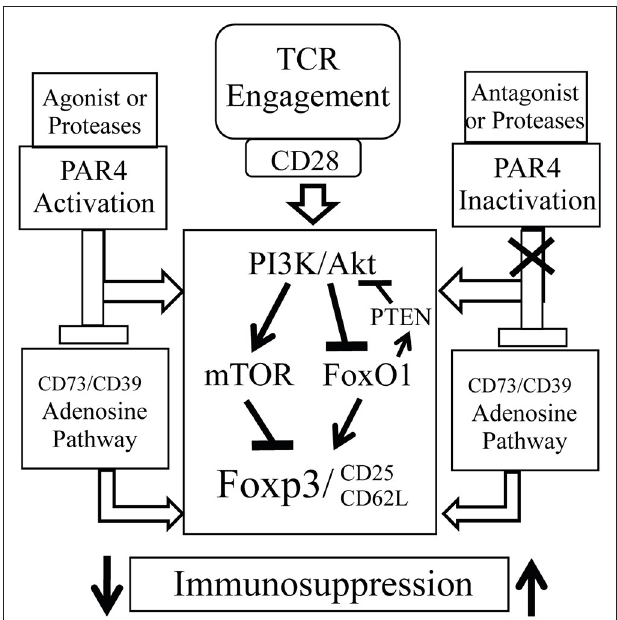
FIGURE 7 | Possible underlying mechanism of PAR4 signaling. PAR4 activation may directly activate PI3K/AKT pathway, which then upregulates the activity of the downstream effector mTOR and downregulates the activities of Foxo1 and PTEN, and subsequently controls the expression of Foxp3, CD25, and CD62L. However, accumulation of excessive proteases at the sites of inflammation may overregulate PAR4 signaling on various cell types including Tregs, which then reduces function, stability, and mobility of Tregs. Moreover, PAR4 activation may also negatively control adenosine pathway. Once removing PAR4 signaling, the negative regulator, these Tregs possess “super” capacity with a Foxp3 high CD25 high CD62L high phenotype and are able to induce immune